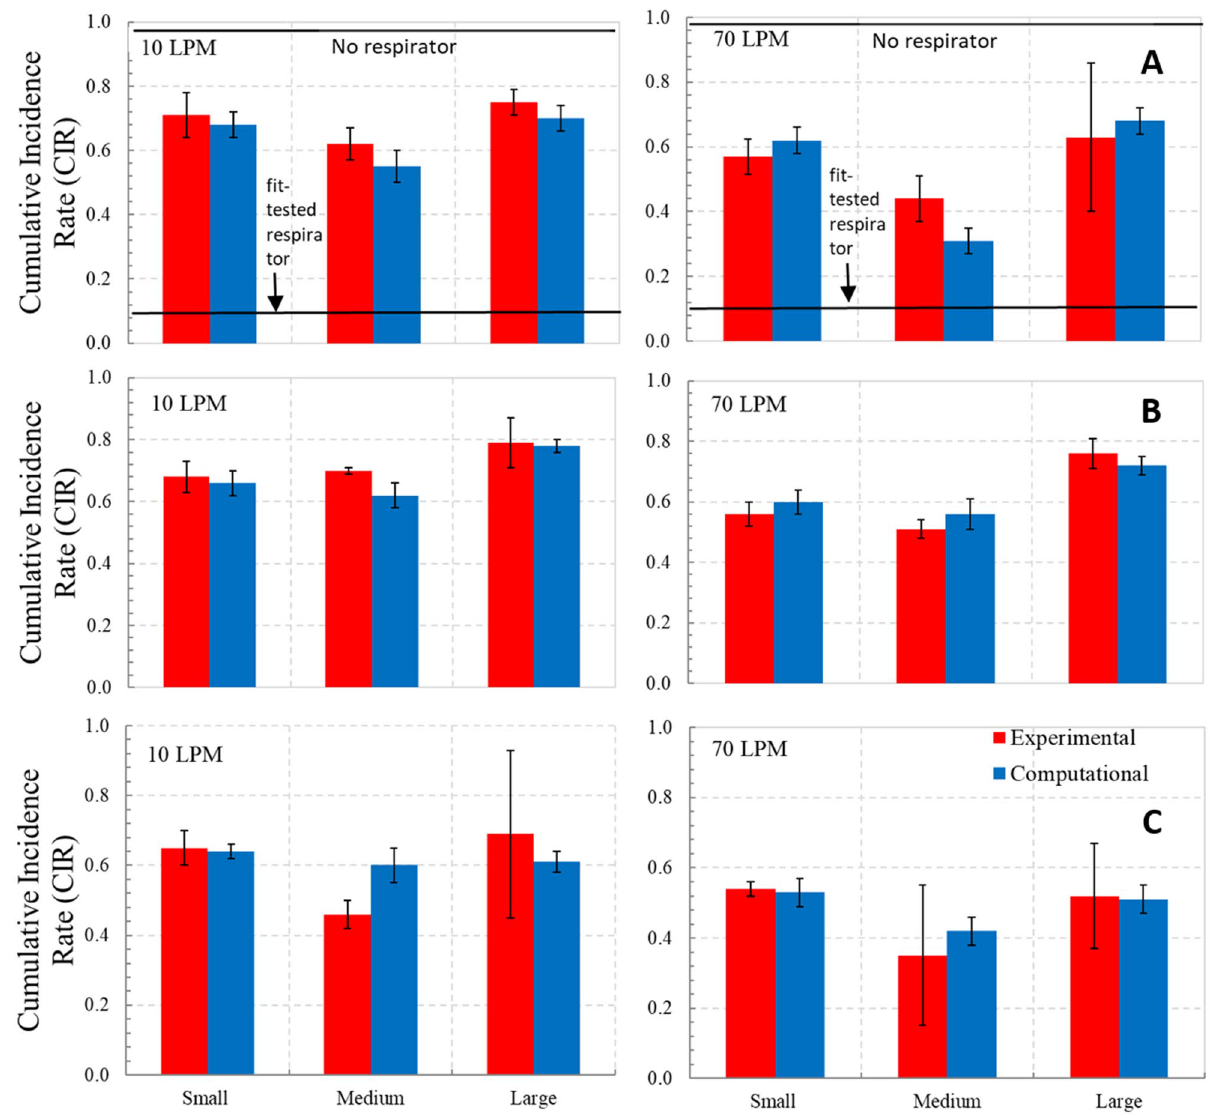
Figure 10. Cumulative Incidence Rates (CIR) from experimental and computational aerosol leakage for 10 LPM and 70 LPM ( A ) Respirator, R1 ( B ) Respirator, R2 ( C ) Respirator, R3; n = 3 for